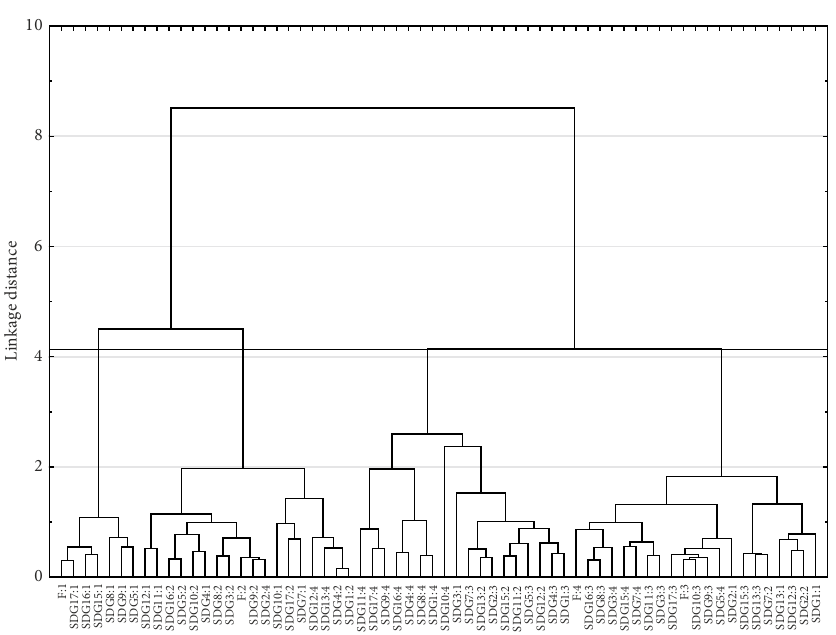
Figure 2. The results of the correspondence analysis (source: own